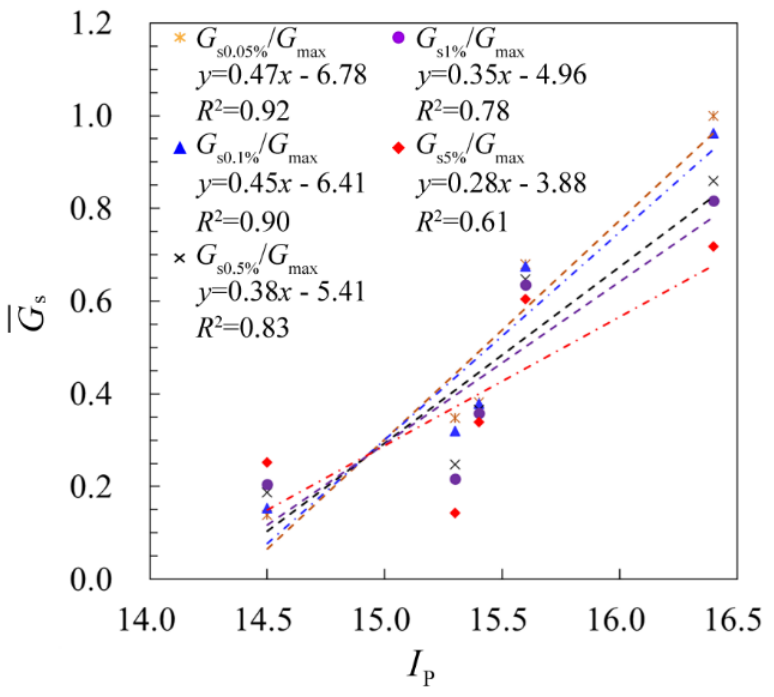
Figure 14. Correlation of normalized shear modulus with plasticity index I P at different shear strains (i.e., γ = 0.05%, γ = 0.1%, γ = 0.5%, γ = 1% and γ = 5%).